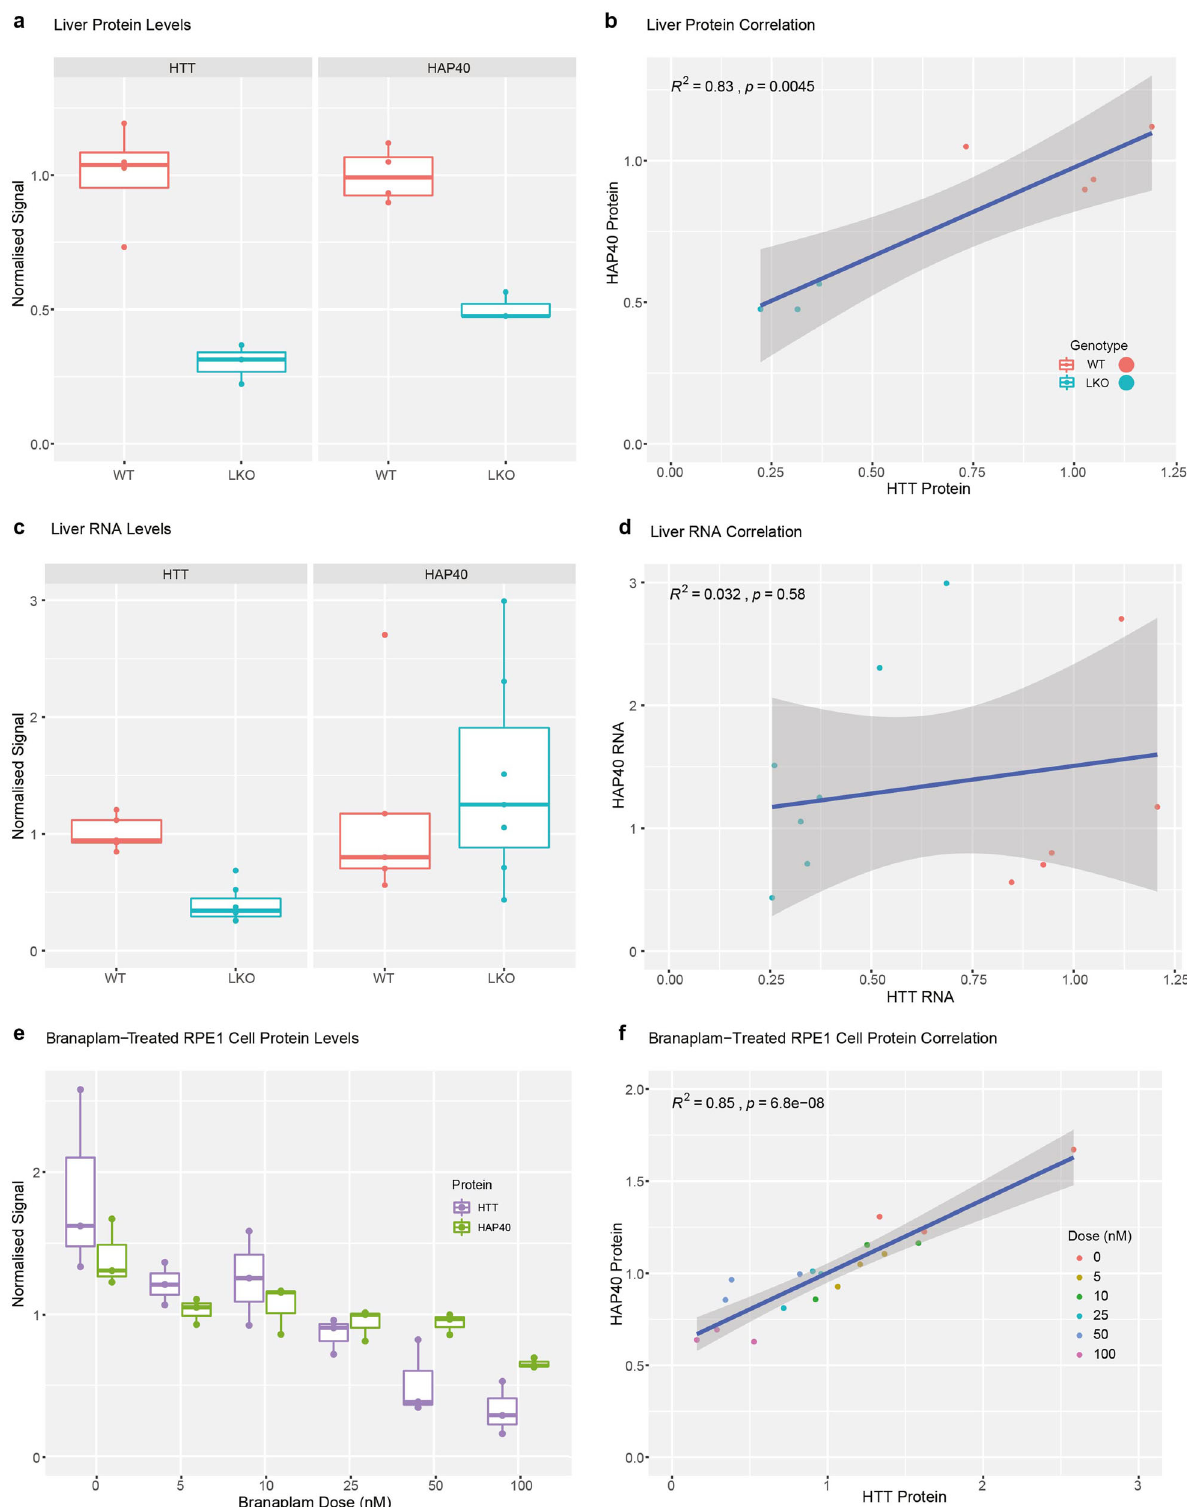
key differences exist between the two models (Fig. 2d). Two additional C-terminal α -helices in the HTT C-HEAT domain spanning residues 3105 – 3137 are resolved in our model (all residue numbering based on HTT NCBI reference NP_002102.4 sequence), whereas the resolution of two N-terminal α -helices of HAP40 spanning residues 42 – 82 is lost. The unmodi fi ed native HAP40 C-terminus in our model is able to